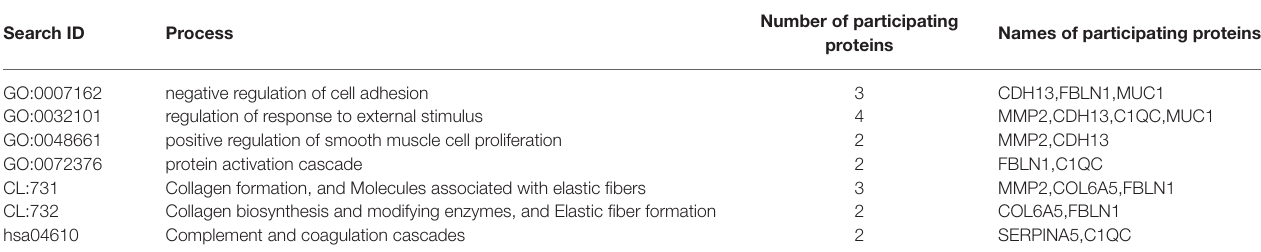
TABLE 2 | Characteristics of the main processes regulating HRV common to the blood and urine proteome in the baseline period. Search ID